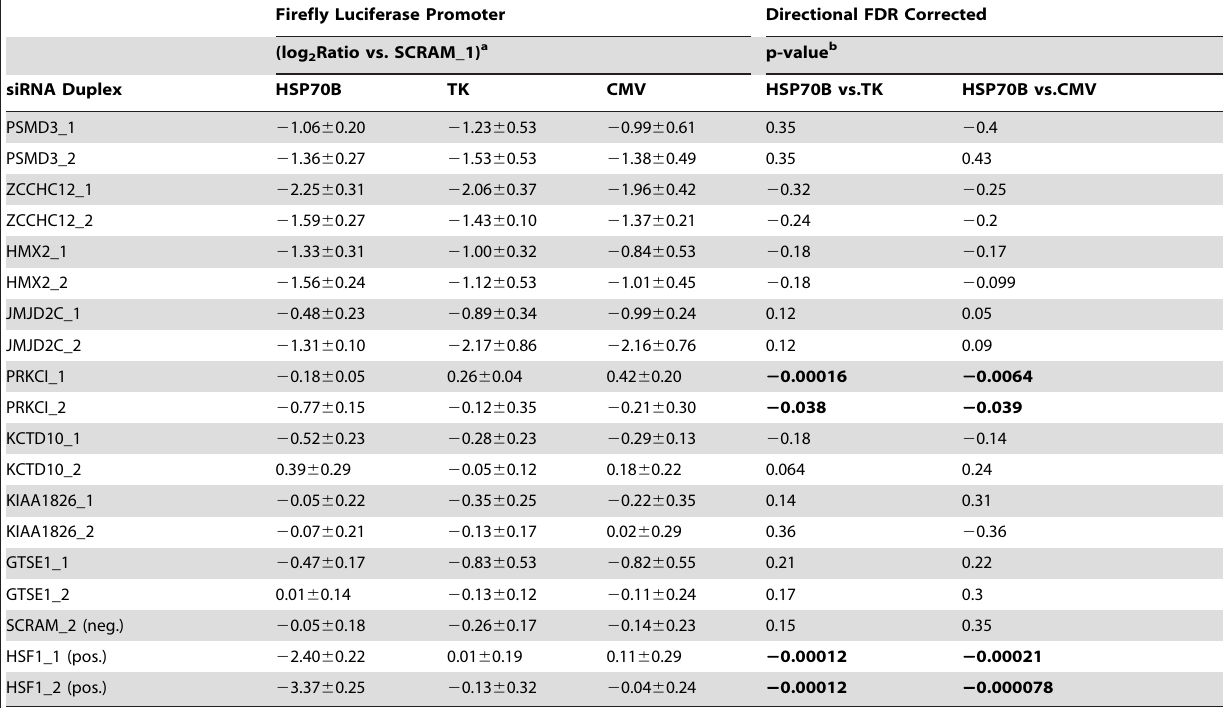
Table 2. Validation of potential HSF1 regulators using